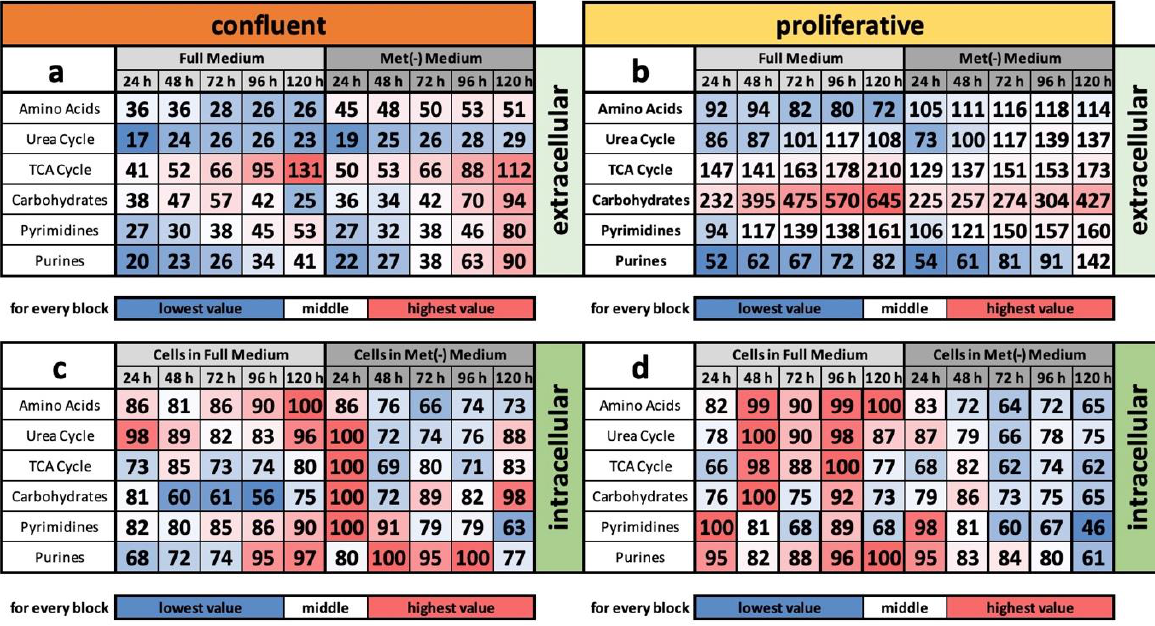
Figure 3. ( a – d ) Overview of individual metabolic classes and metabolic groups under MetR in a comparison between confluent and proliferative conditions in the cell line L929. The metabolism of the murine cell line L929 was analysed in full medium and MetR under both confluent ( a , c ) and proliferative conditions ( b , d ) over a period of 5 days. For each day of the experiment, the preparation was performed in triplicate. After 24, 48, 72, 96 and 120 h, both the medium (extracellular) and the cell lysates (intracellular) were analysed by LC/MS. The results were reproduced in four independent experiments and finally summarised. This figure shows the results of selected classes of substances and metabolic pathways. For the values of the media, the control measurement of the medium used was defined as 100%. For the cell pellets, the highest measured value in each test series was defined as 100%.